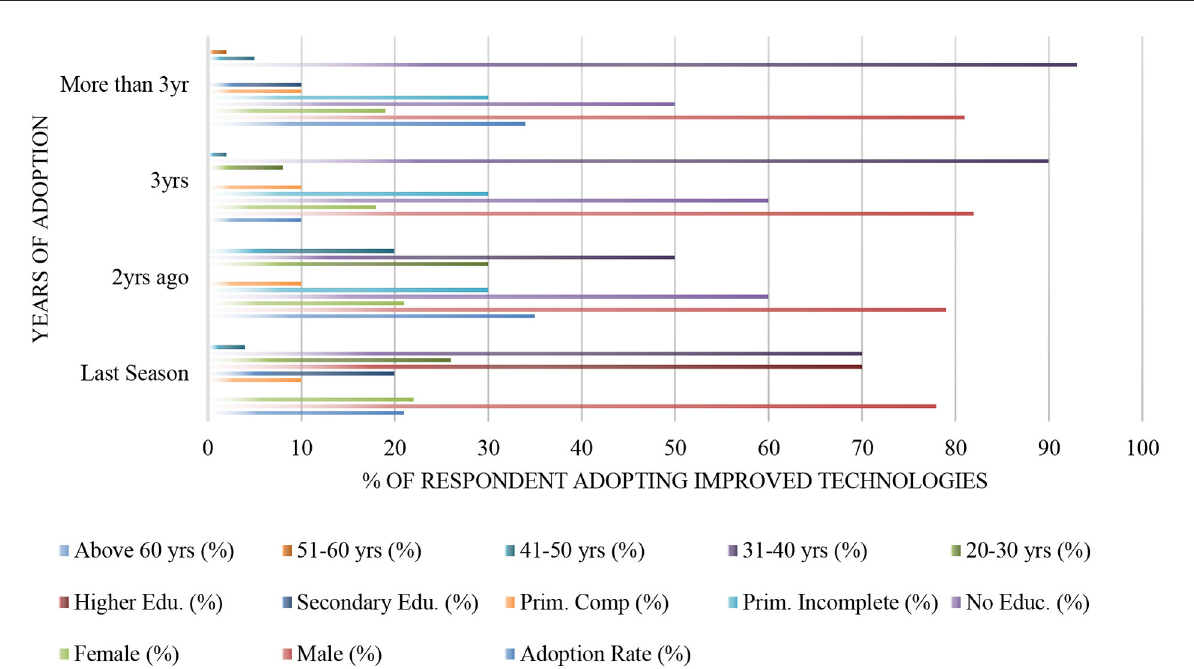
FIGURE6 Distribution showing respondent year(s) of adoption of improved technologies. Hy, Hybrid; OPV, Open Pollinated Varieties. This figure compares the overall adoption rate of improved technologies with the number of years respondents have been adopting technologies, their age category, level of education and gender. Author, 2021.